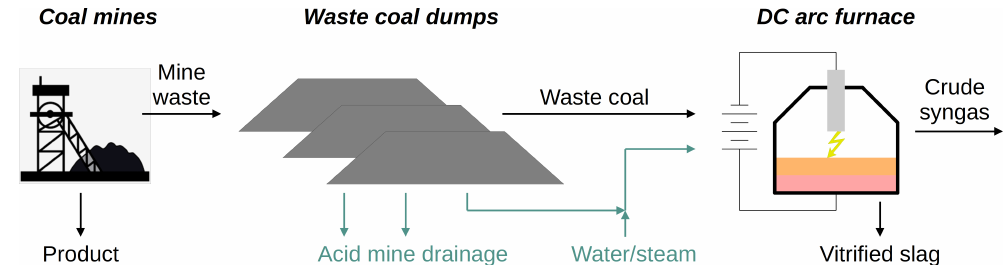
Figure 1. Application of DC arc furnace technology to the valorisation of waste coal using plasma